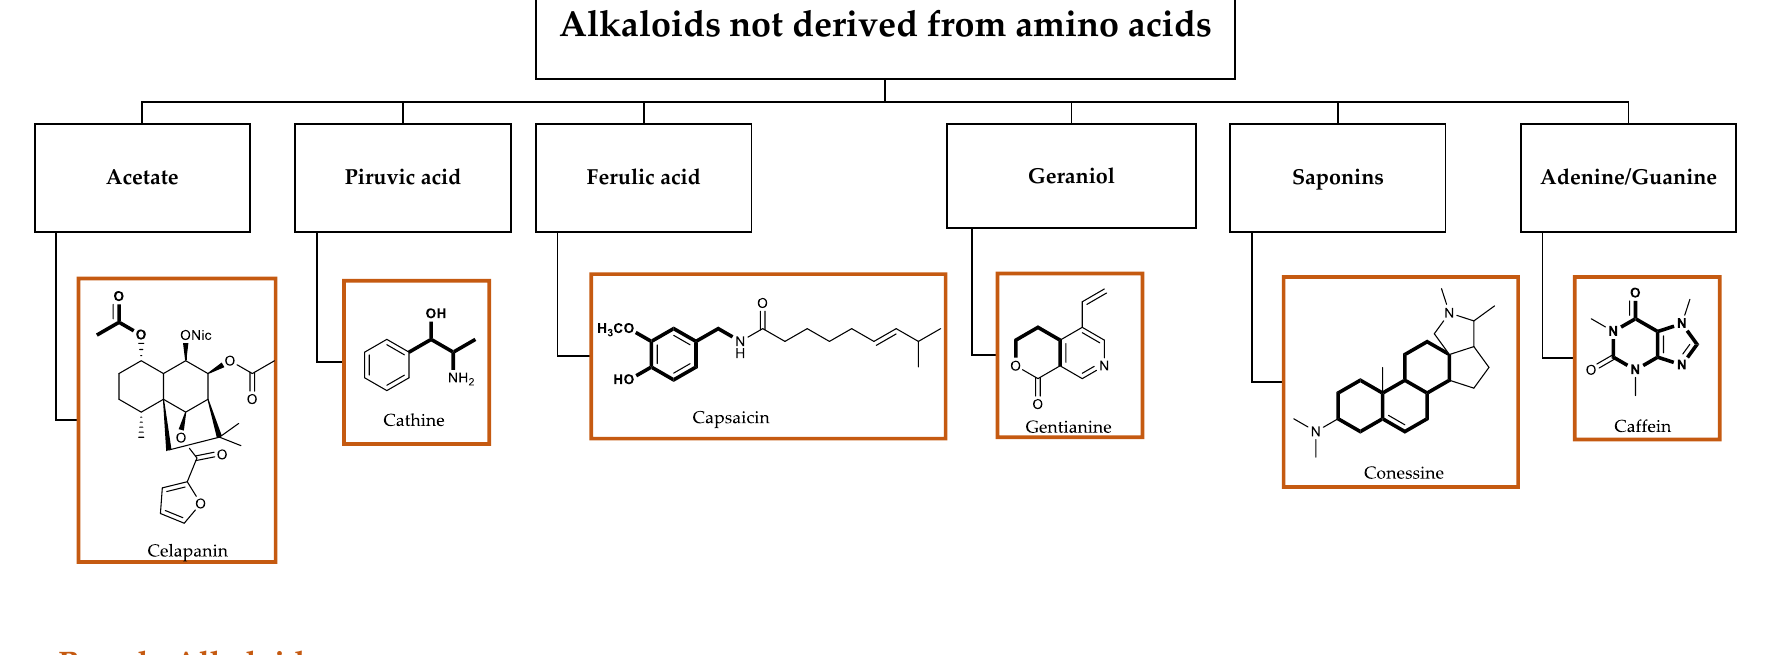
Figure 2. Schematic representation of pseudo-alkaloids. The carbon skeleton derived from the natural precursor is in bold.